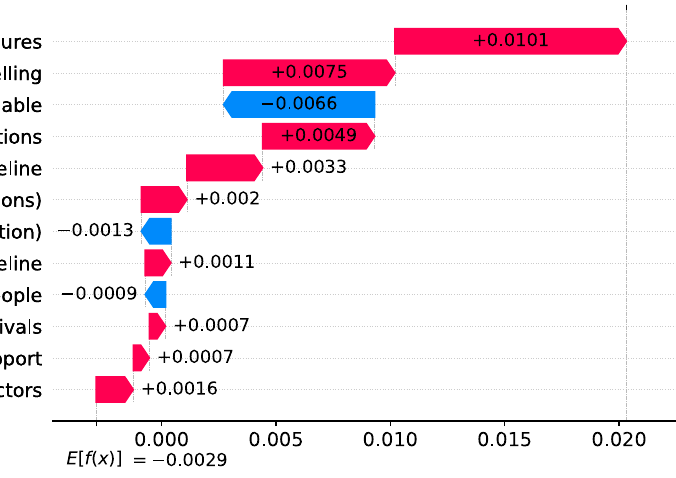
Fig 23. (Color online) factors driving acceleration in Germany on the 20 th day.